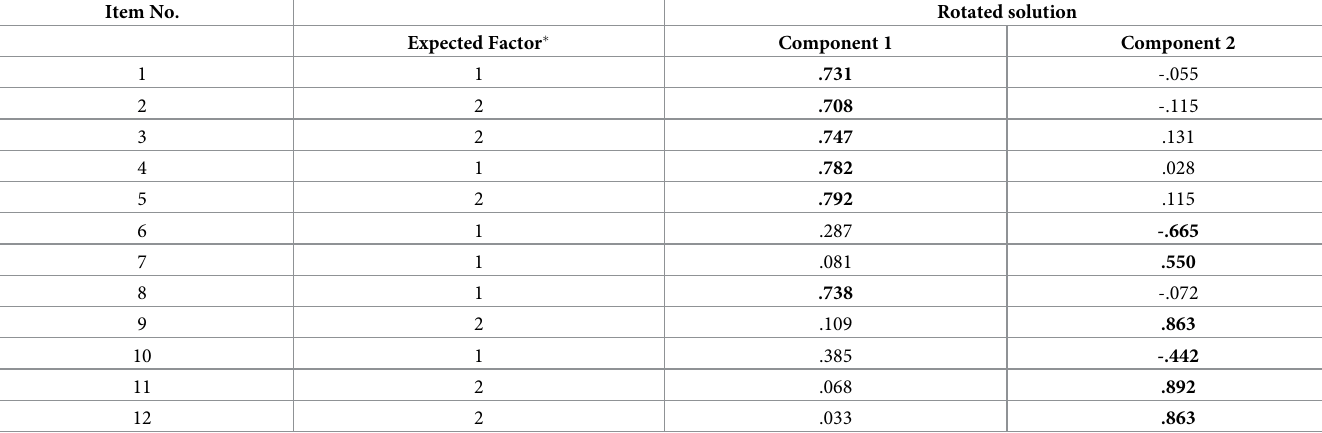
Table 2. Factor loadings derived from EFA using principal axis factors method (rotated component matrix). Item No.